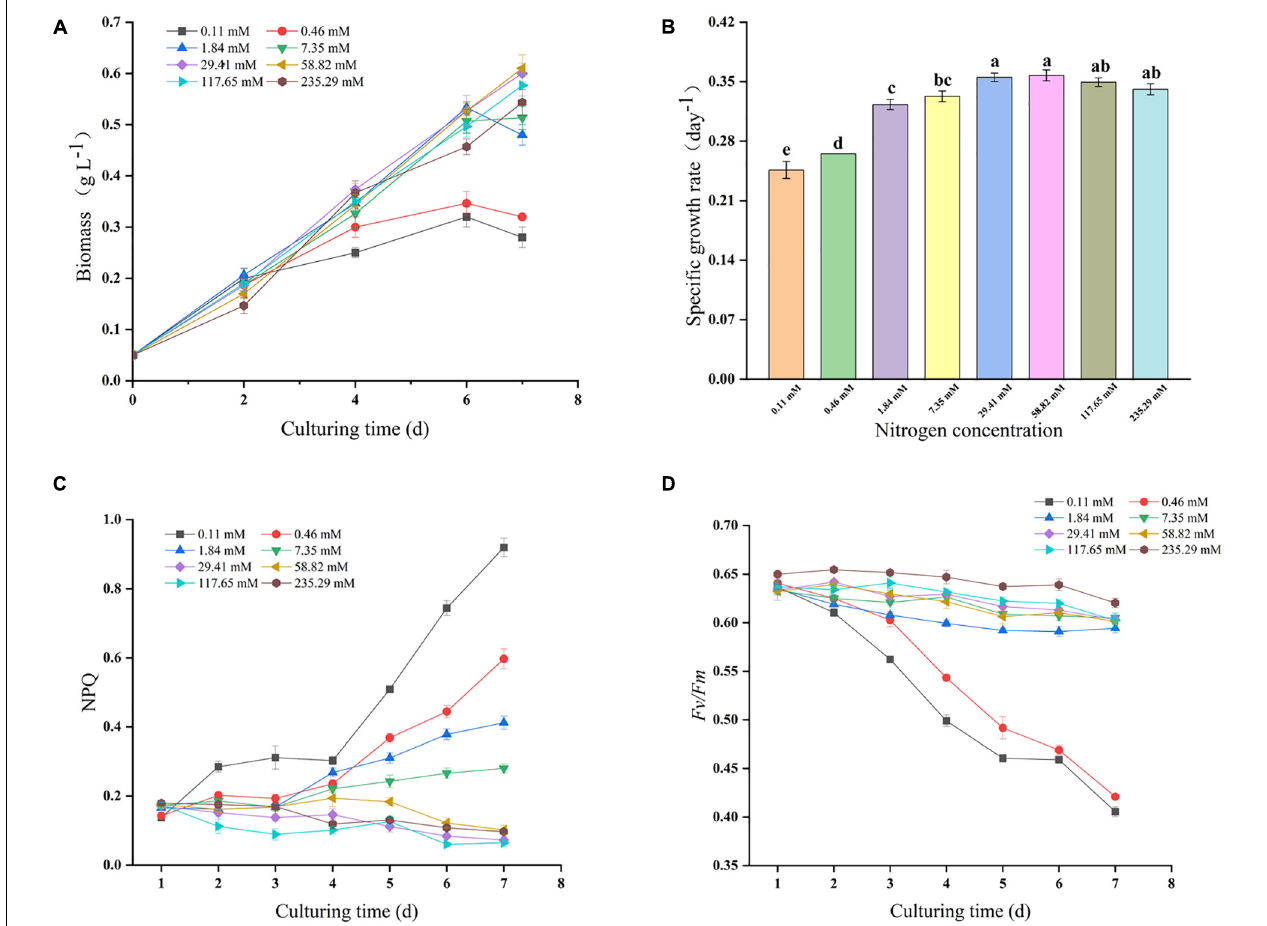
FIGURE 1 | Growth and photosynthetic performance of Nitzschia sp. NW129 under different nitrogen concentrations. Growth curves (A) . Specific growth rate (B) . Non-photochemical quenching (NPQ) (C) . Maximum quantum yield ( Fv/Fm ) (D) . Values are given as mean ± SD, n = 3. Letters indicate statistical differences, which was analyzed by a one-way ANOVA with an alpha value of